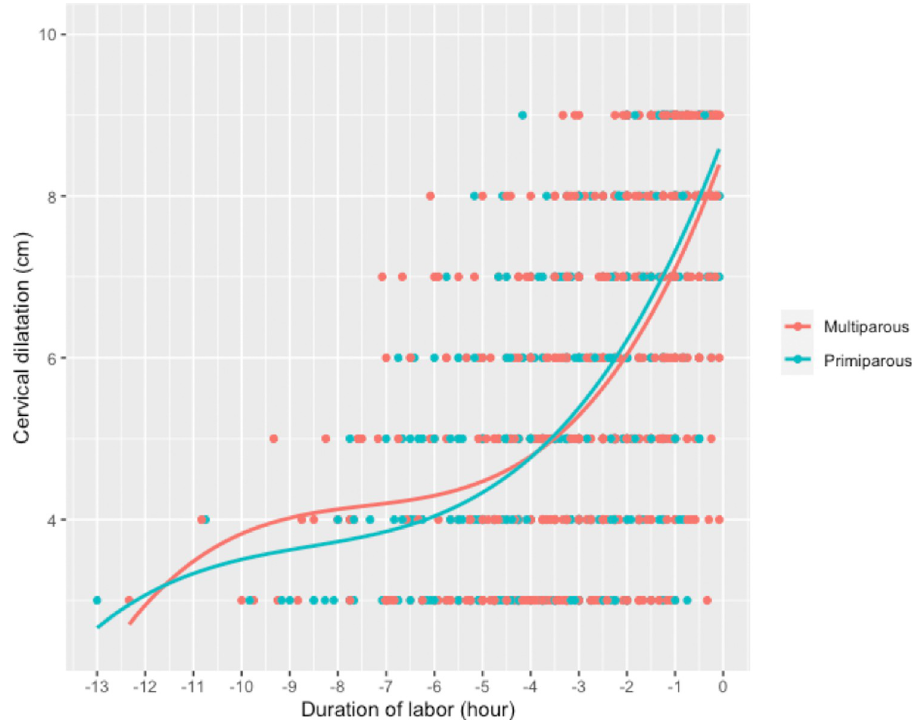
Fig 3. Cervical dilatation curves for the primiparous and multiparous women.